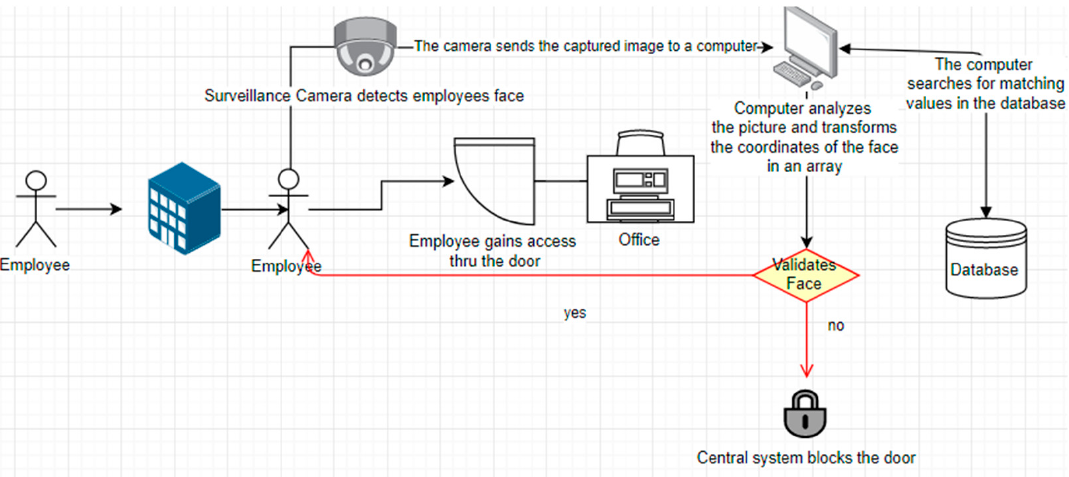
Figure 14. The author’s vision on the implementation of an authorization system for employees.